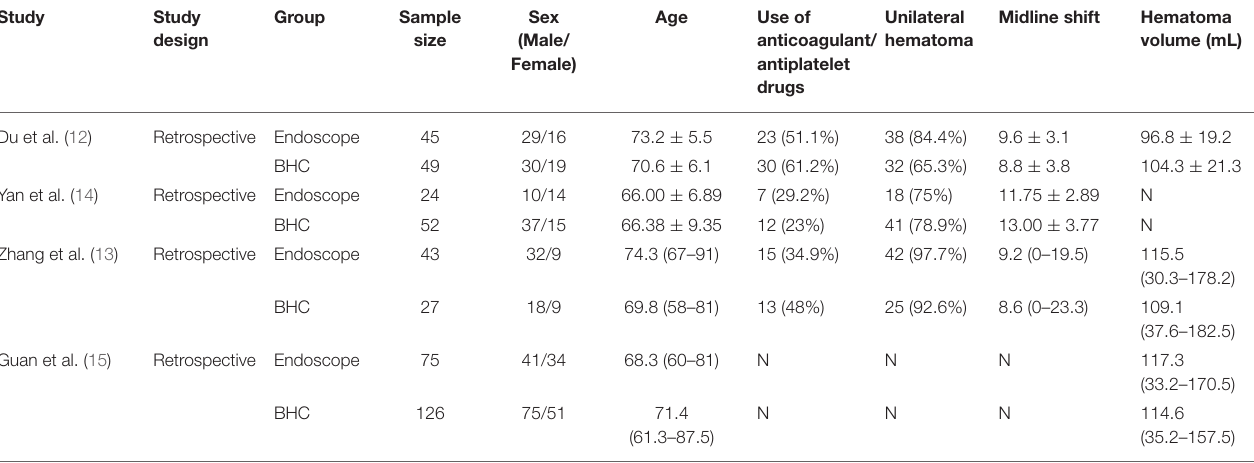
TABLE 1 | Baseline characteristics of included studies.